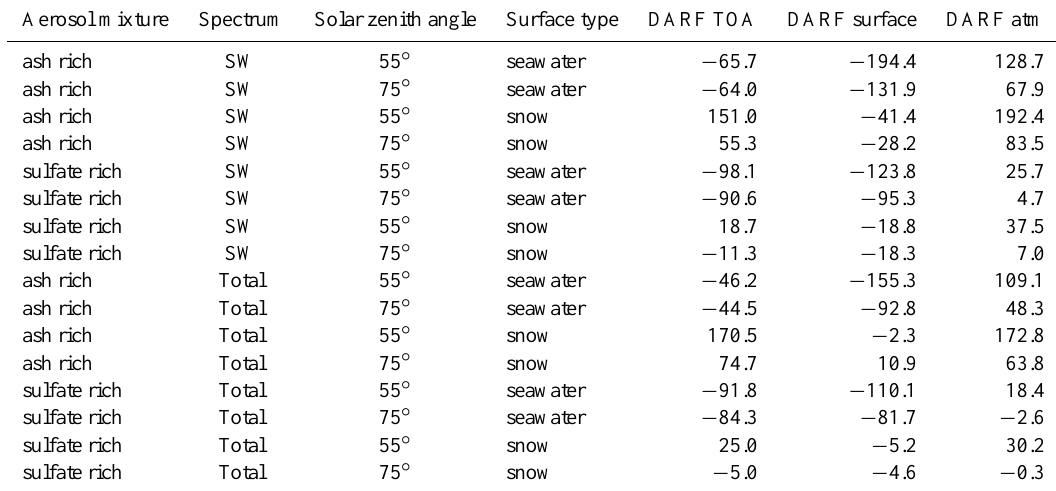
Table 2. Shortwave (SW) and total DARFE for a thin ( ∼ 2.5–7km) plume in Wm − 2 AOD − 1 . DARFE was calculated for a range of AOD between 0.18 and